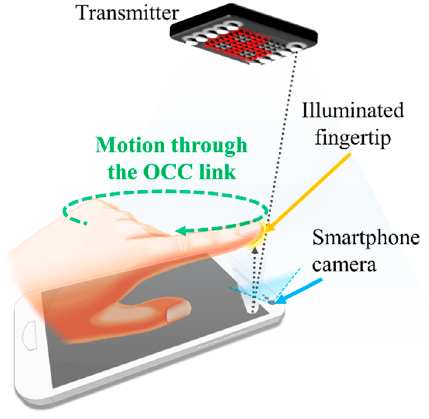
Figure 29. A motion over camera scheme.